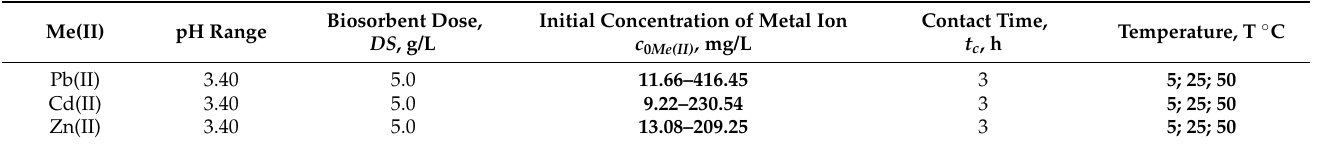
Table 6. The values of the working parameters used in the experimental study of the influence of temperature on the biosorption